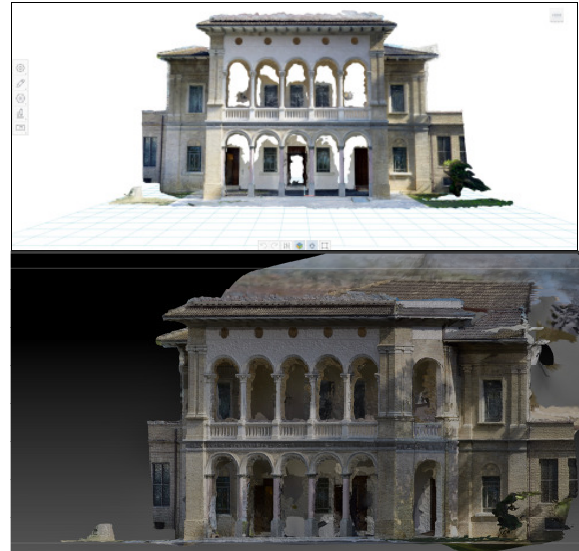
Figure 8. Digital model of the artifact obtained after point cloud computing by Recap Photo